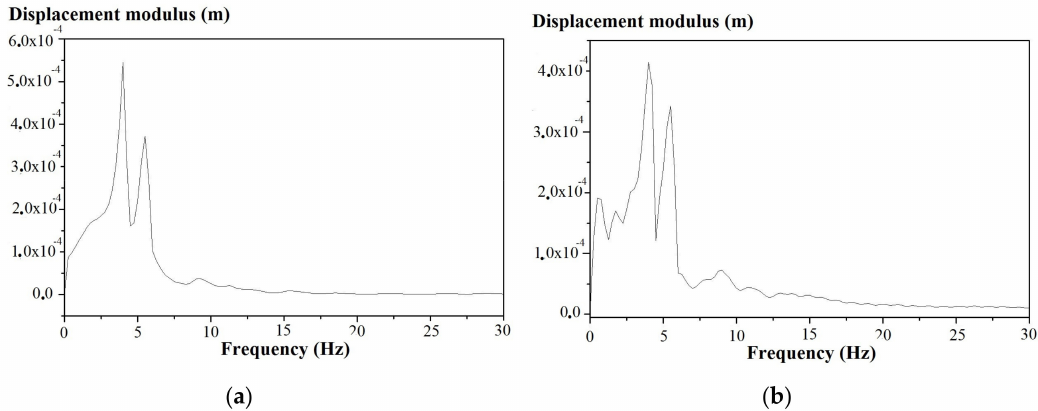
Figure 16. Laser Doppler vibrometer signal spectrum at the middle section intrados in the ( a ) un-reinforced and ( b ) reinforced